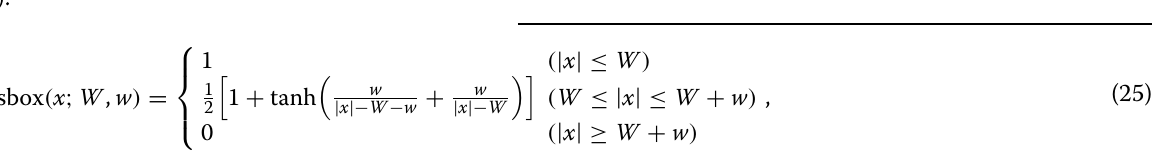
where τ ∗ is the steady-state frictional resistance at the = V ∗ − B reference V , and A represents the steady-state rate dependency. Note that the value of τ ∗ is insignificant, as a linear poroelastic material is considered; spatial vari- ation in τ ∗ is absorbed by definition of the initial or refer- ence state from which the slip δ is measured. A and B are the amounts of direct and evolution effects, respectively. The rate-weakening patch is expressed using a smoothed boxcar function (The SCEC/USGS Spontaneous Rupture Code Verification Project, TPV105; Noda and Lapusta